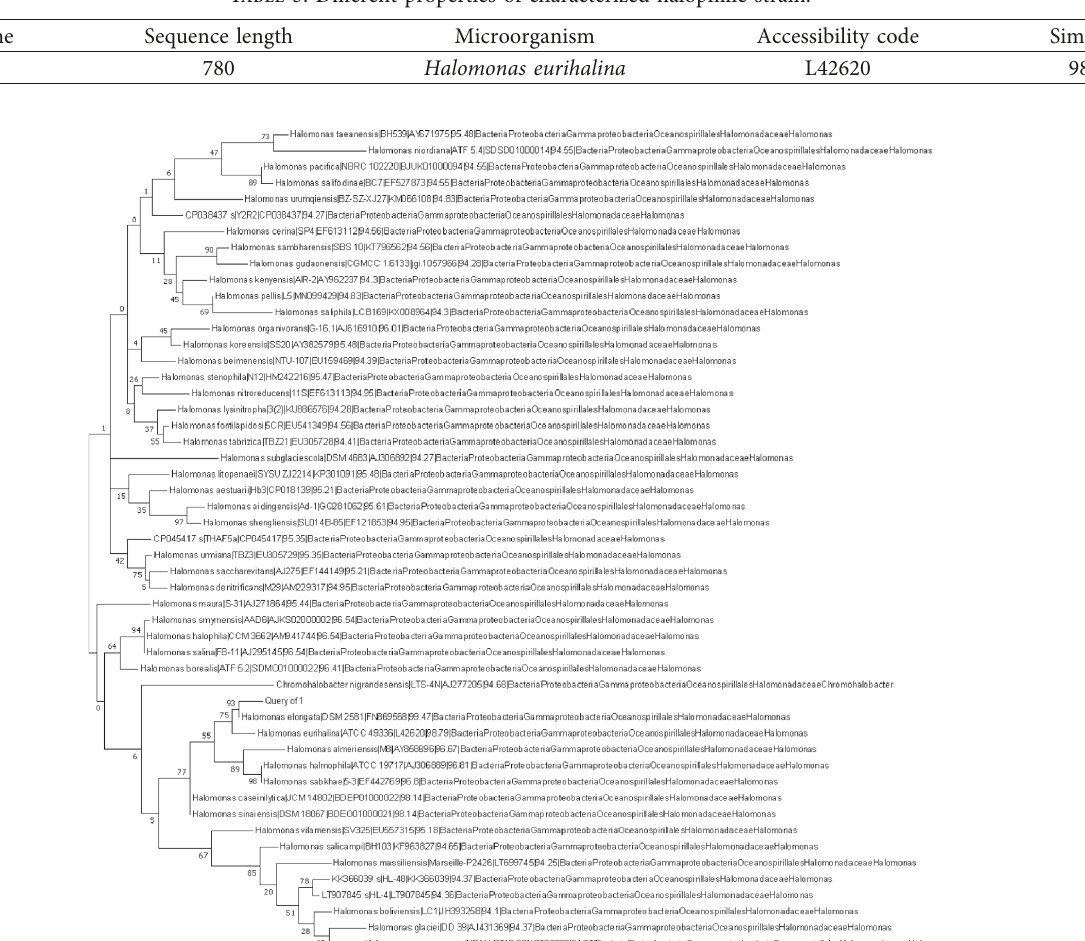
Table 5: Different properties of characterized halophilic strain.